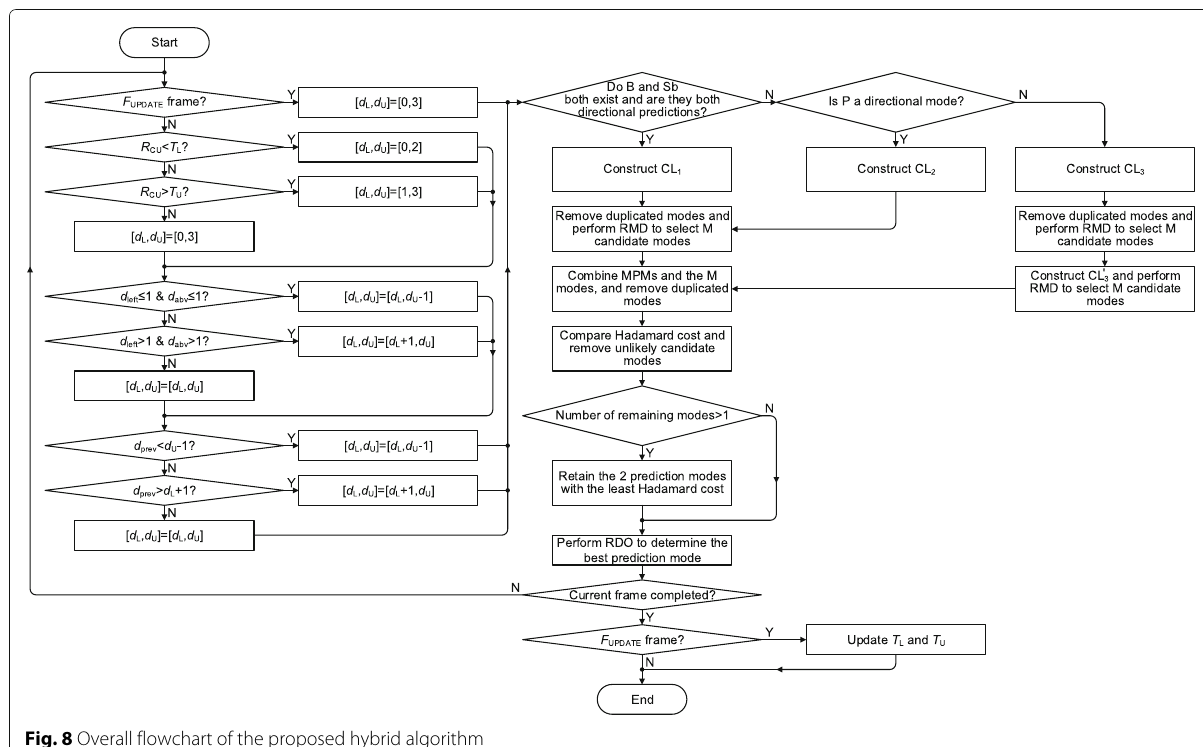
Fig. 8 Overall flowchart of the proposed hybrid algorithm